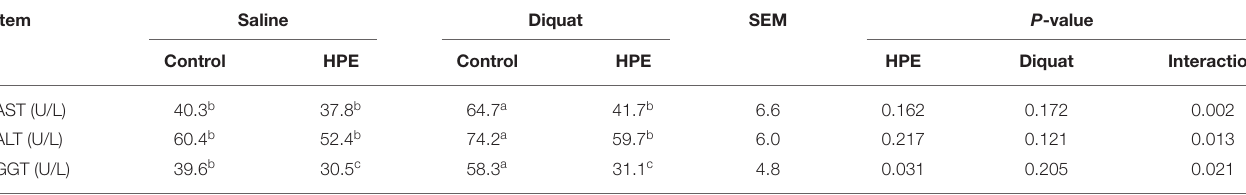
TABLE 2 | The plasma biochemical parameters of the piglets fed holly polyphenols extracts (HPE) diet with diquat challenge. Item Saline Diquat SEM P -value Control HPE Control HPE HPE Diquat Interaction AST (U/L) 40.3 b